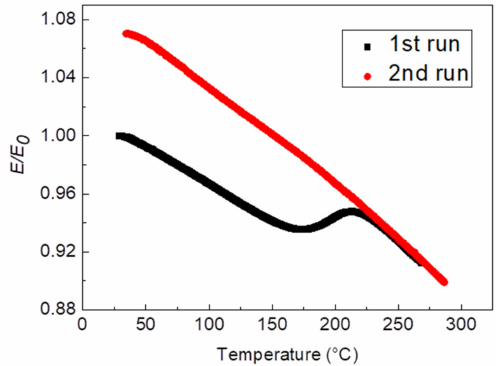
Figure 12. Dynamic modulus E vs. temperature of the AlSi10Mg alloy manufactured by L-PBF measured in two successive test runs. The values of dynamic modulus are normalized to the value E 0 measured at room temperature in the 1st test run. Redrawn from ref. [109] (reproduced with permission from Journal of Alloys and Compounds; published by Elsevier,